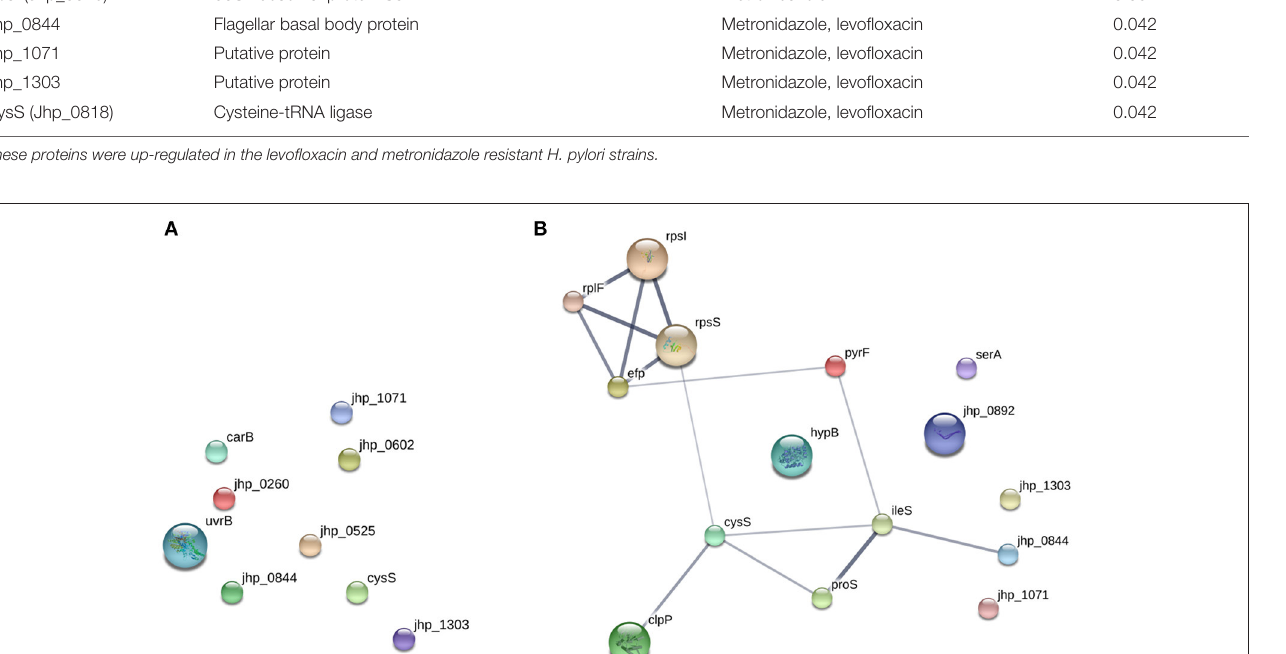
of either positive or negative epistasis (Schenk et al., 2013).